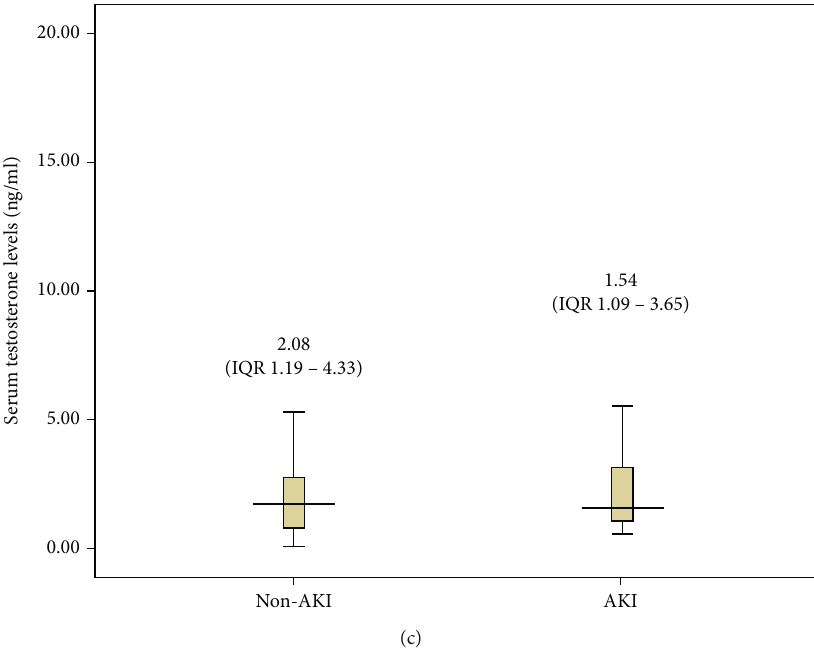
Figure 1: Comparison of serum sex hormone levels in patients with MSAP and SAP. (a) Estradiol and (b) progesterone and (c) testosterone levels in MSAP and SAP patients. The serum sex hormone level was determined during the fi rst 48 hours following admission. Patients without AKI were identi fi ed by the left bars, and patients with AKI were identi fi ed by the right bars. Medians and interquartile ranges (IQR) were shown above each plot. Statistical signi fi cance was determined with the two-sided Mann-Whitney U test. Note: AKI: acute kidney injury; MSAP: moderately severe acute pancreatitis; SAP: severe acute pancreatitis. Table 3: Binary logistic regression analysis of predictive factors for the complication of acute kidney injury in patients with MSAP and SAP. Univariate analysis Multivariate analysis Variables